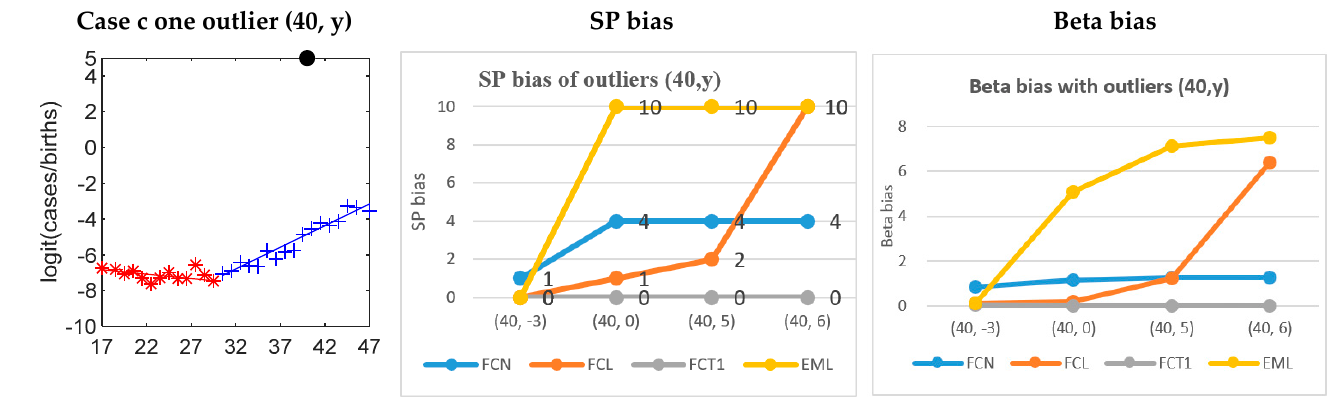
Figure 7. Comparisons of cases (a) and (c); data in case (c) are contaminated by one outlier (40, y), y = − 3, 0, 5, 6, respectively.